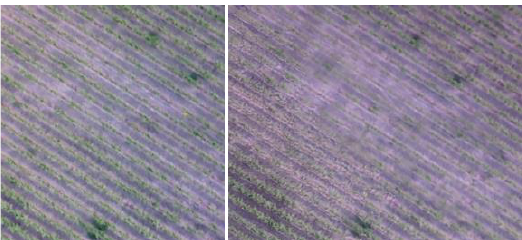
Figure 6: Result of vine identification algorithm using VIS data alone (left) and (right) close up view (Region 1). The same area is shown in Figure 8.